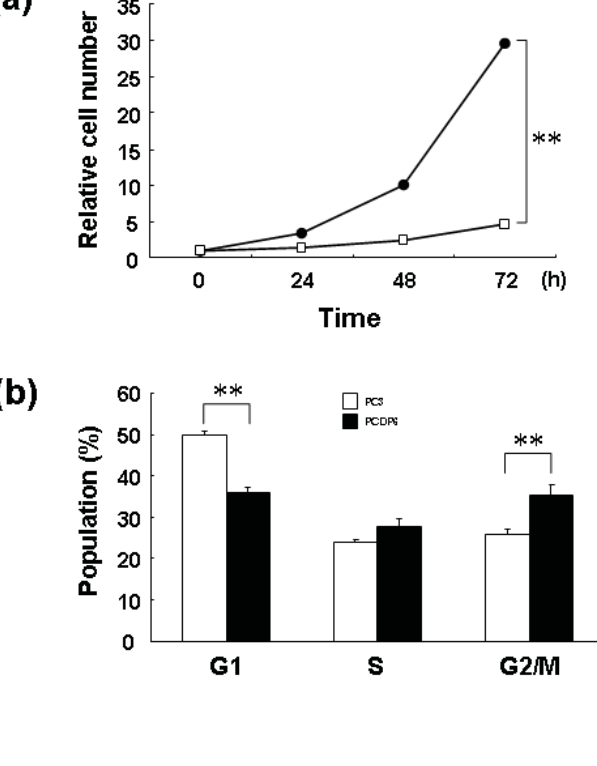
Figure 6. Proliferation rates of PC3 and PCDP6 cell lines. ( a ) Cells were counted at the indicated times, with time zero being 24 h after seeding. Results were normalized to cell numbers at 0 h. The points represent the mean of at least three independent experiments; the bars show the SD. ** P < 0.01; ( b ) PC3 and PCDP6 cells were harvested, stained with propidium iodide and DNA content in single cells was measured by flow cytometry. * P < 0.05, ** P <